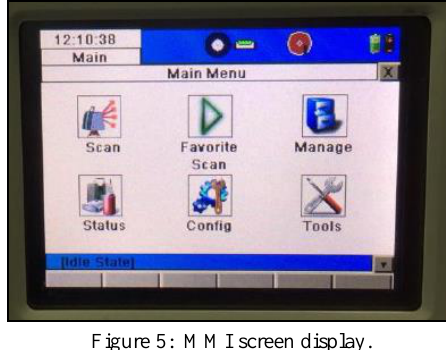
Figure 5: MMI screen